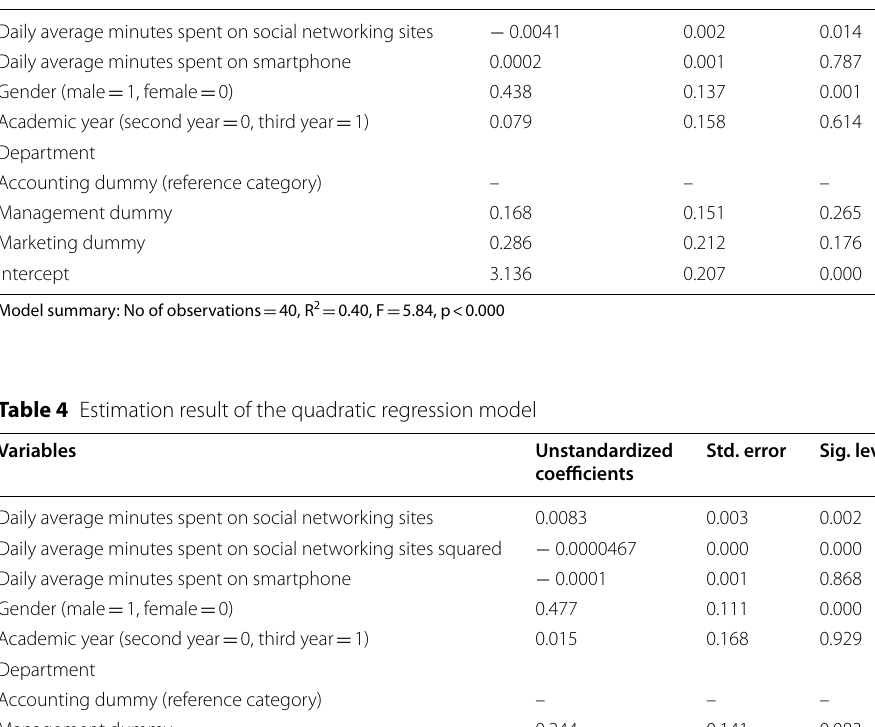
40, R 2 0.61, F 12.75, p < = = =